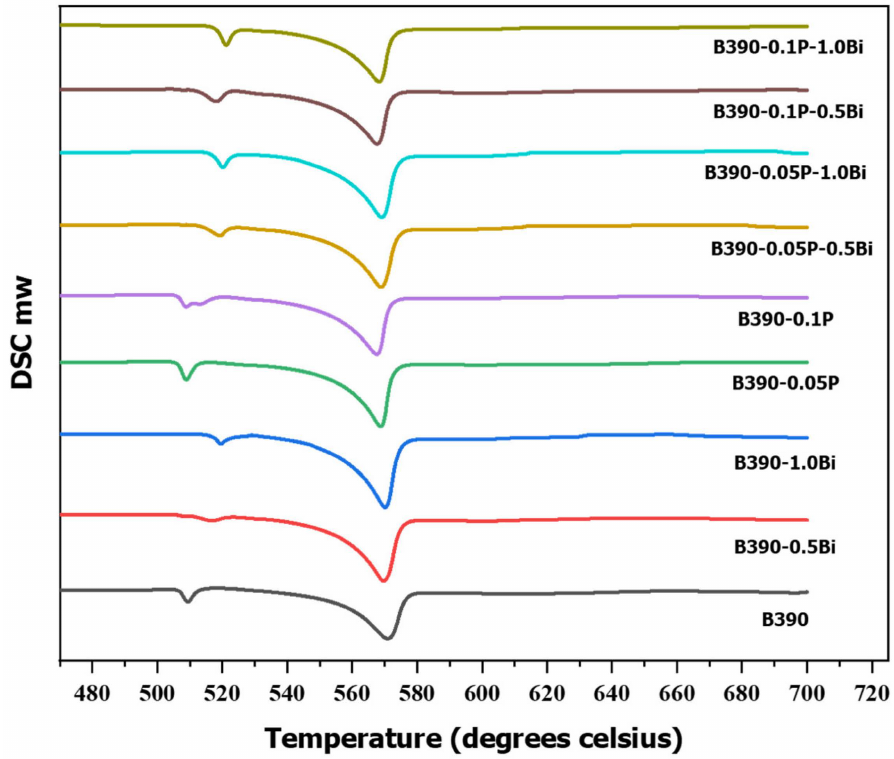
Figure 13. DSC curves at unmodified and modified as-cast